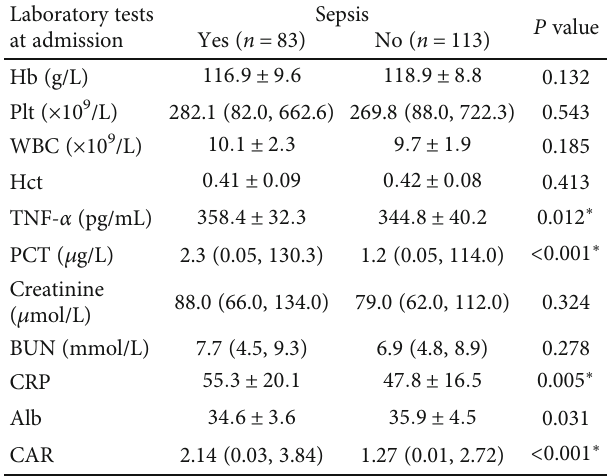
Table 2: Clinical parameters associated with sepsis in severe burns. Table 3: Laboratory tests associated with sepsis in severe